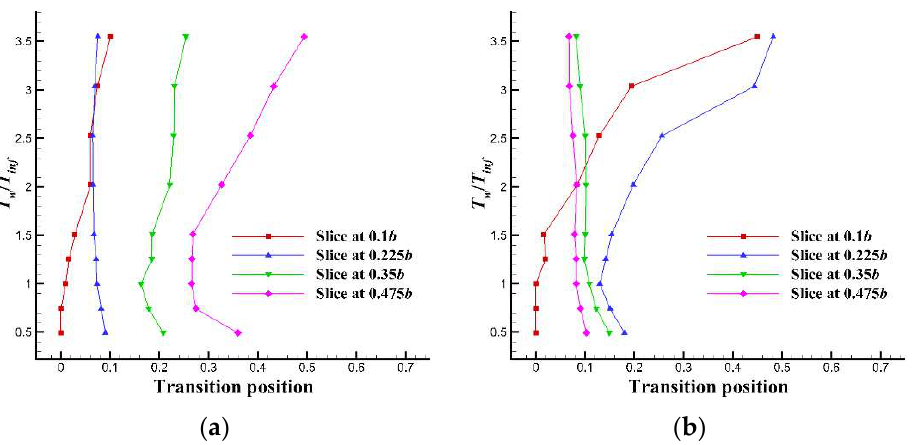
Figure 13. Effect of temperature gradient on transition locations. ( a ) Upper surface; ( b ) lower surface.